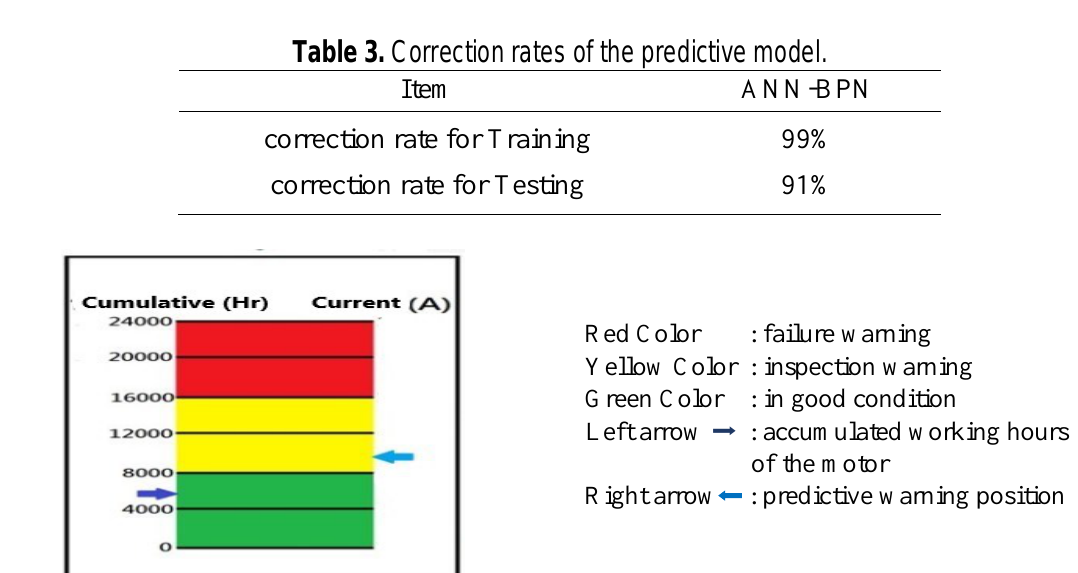
Figure 8. Health Indicator of vertical lift storage